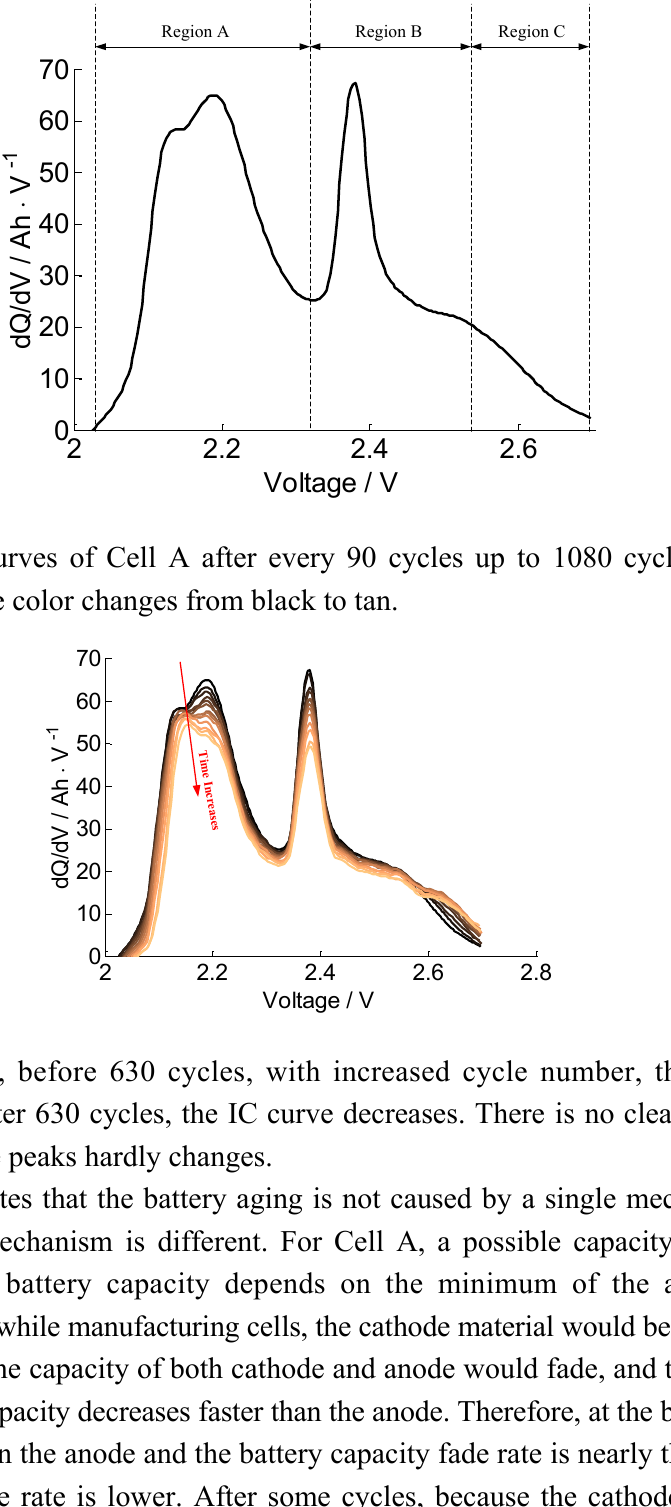
Figure 4. The incremental capacity (IC) curves of new Cell A.